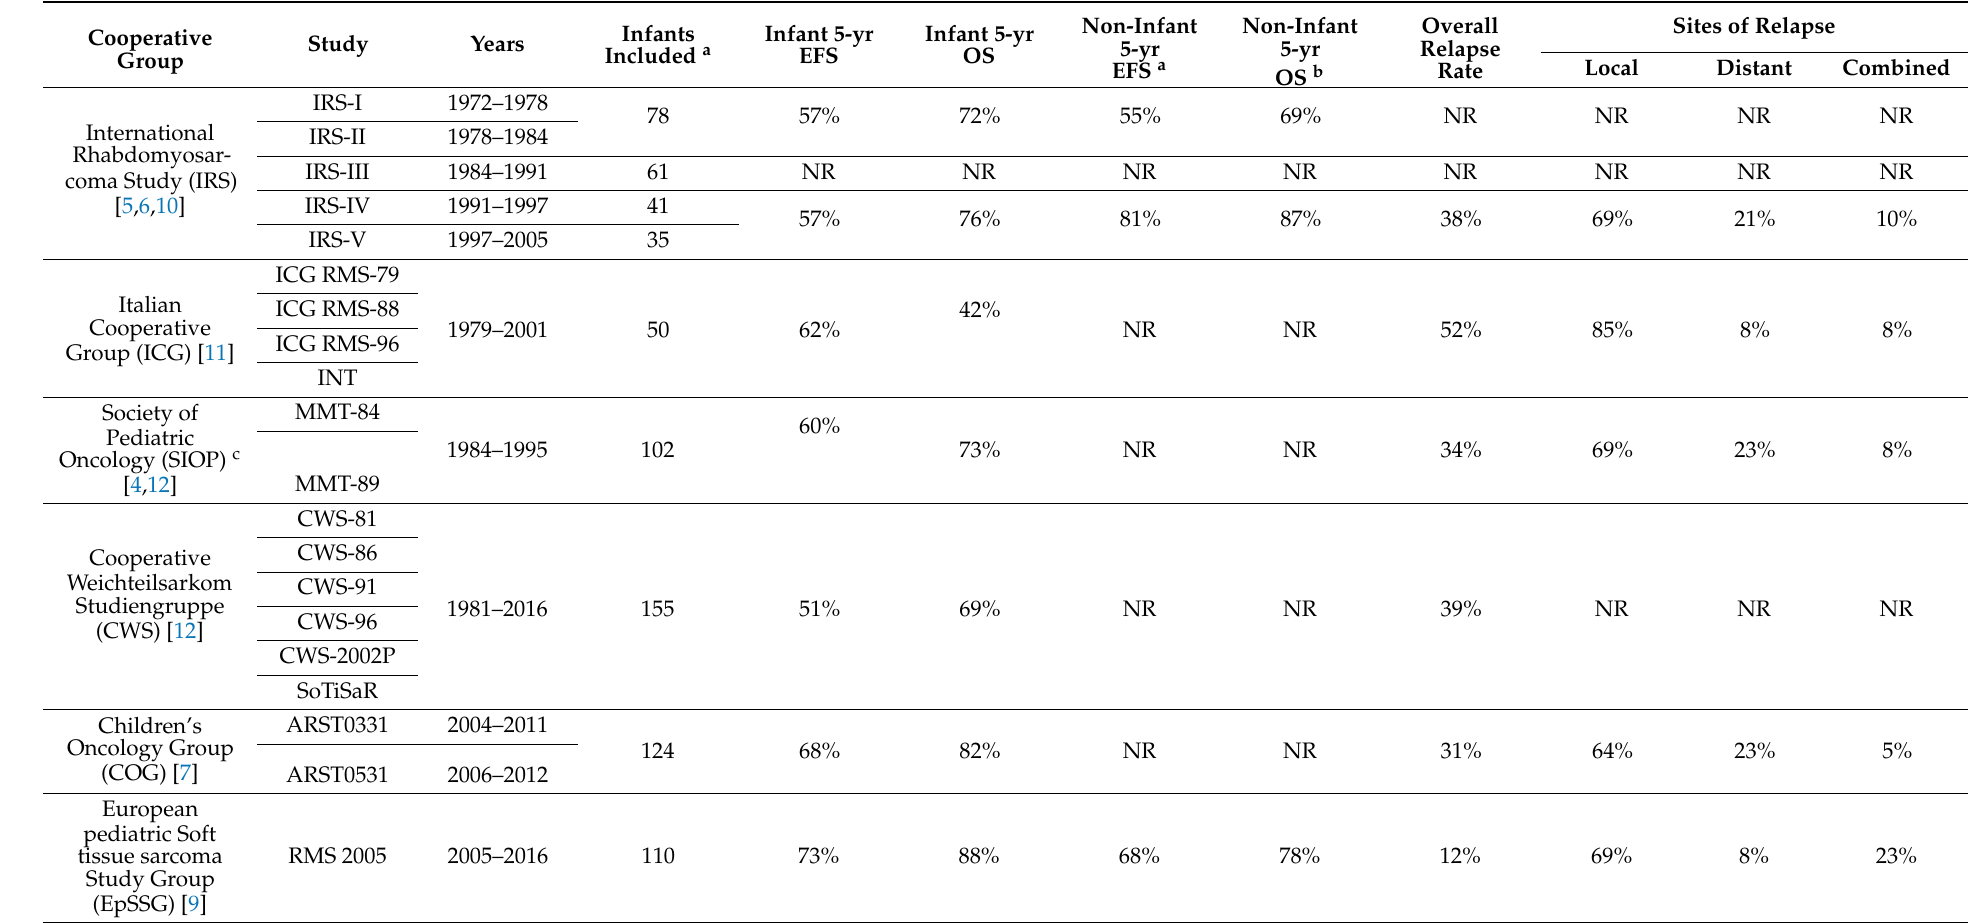
Table 4. Summary of studies of localized rhabdomyosarcoma that included infant (<1 year of age) specific analyses. Cooperative